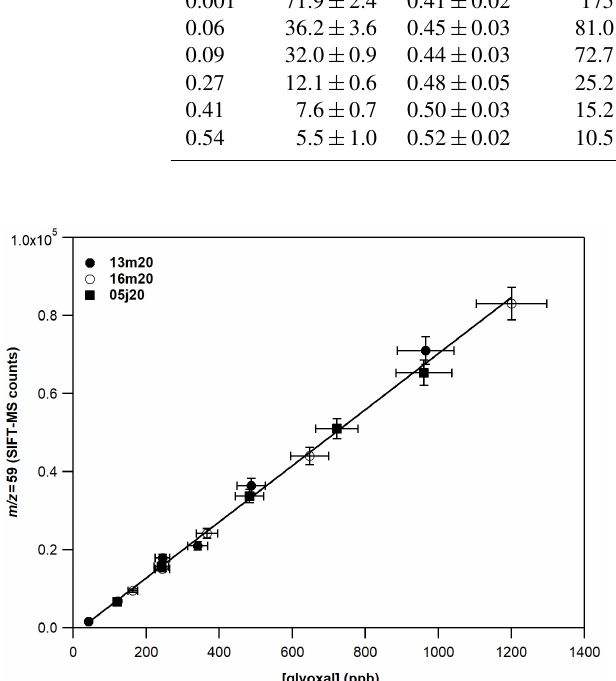
Figure 4. Calibration curves of GL at the m/z 59 derived from the H 3 O + precursor ion under dry conditions. The error bars on the y axis are 5% (extreme value) and correspond to the 2 σ standard deviation of the averaged value of the SIFT-MS signal for each mea- surement. The errors on the x axis are 8% and correspond to the uncertainty given for the cross section value of GL (4%) and other systematic uncertainties (in the flow of the mixture, sampling flow of the instrument, etc.) added in quadrature. Circles correspond to experiments carried out on different days (13 and 16 March 2020) from the same gas mixture. Squares correspond to experiments car- ried out almost 3 months later (5 June 2020) with a new gas mixture and synthesis of